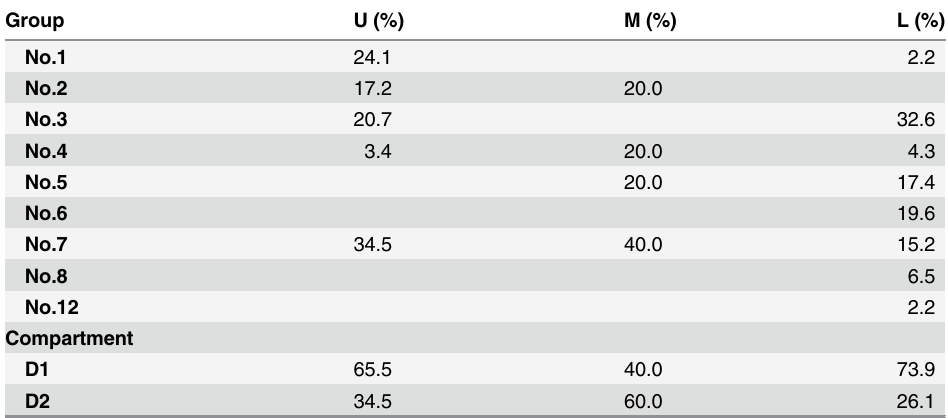
Table 3. The location and distribution of metastatic lymph nodes in gastric cancer.